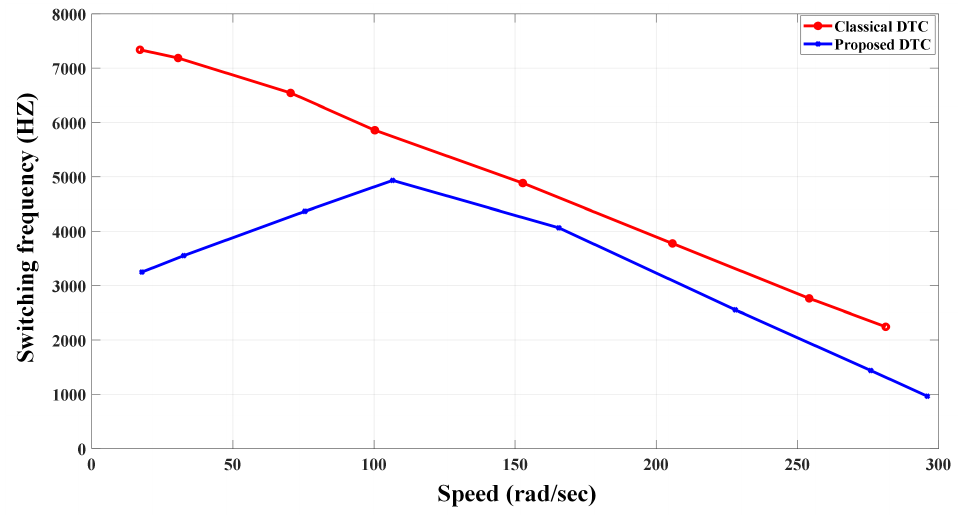
Figure 19. Switching frequency in both the classical and improved strategy.